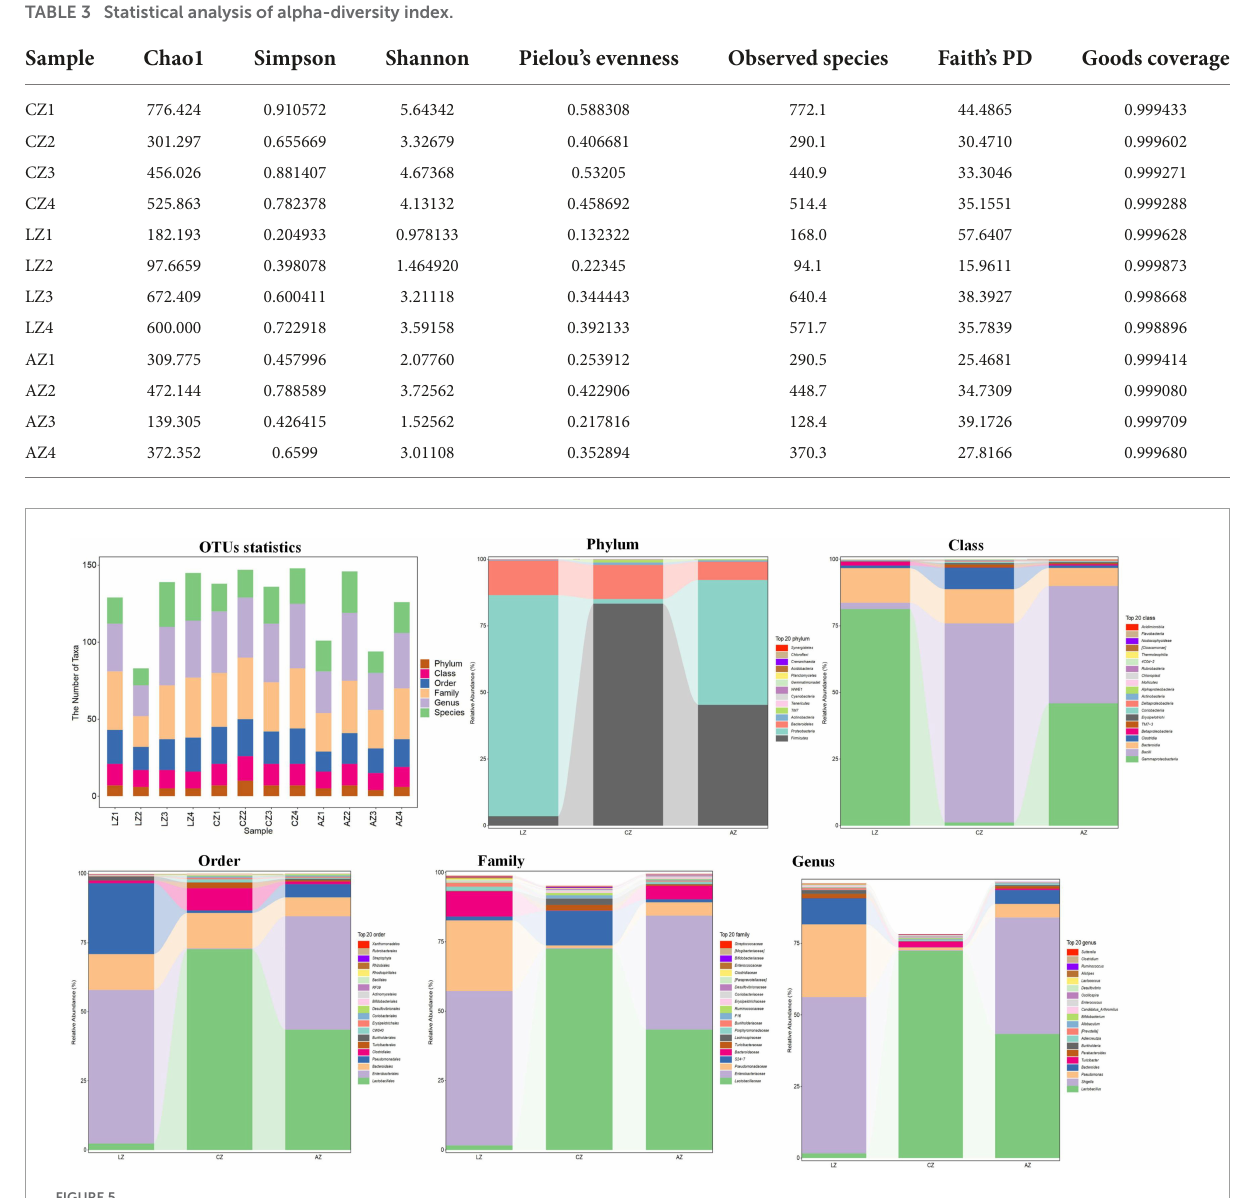
FIGURE5 Effect of dietary sodium acetate/sodium butyrate supplementation on the relative abundance of gut microbiota in different taxa levels.